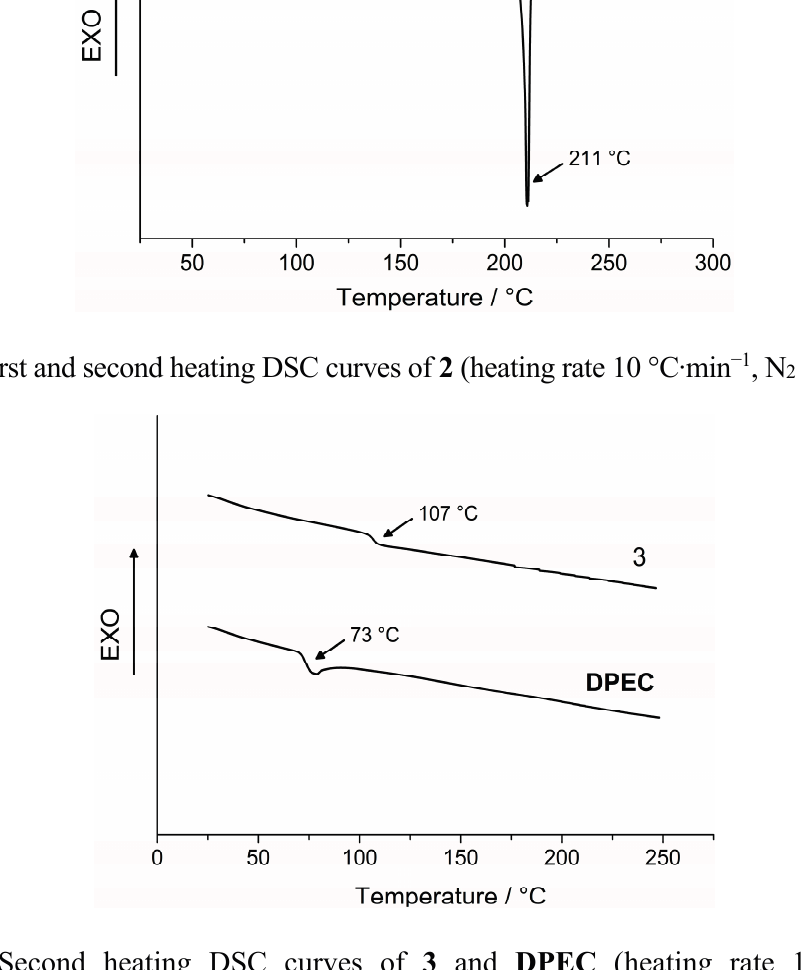
Figure 3. Second heating DSC curves of 3 and DPEC (heating rate 10 °C · min − 1 , N 2